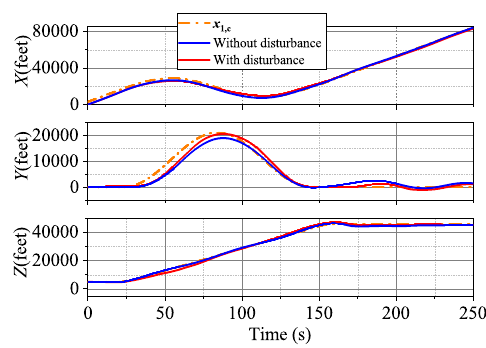
Figure 6. Results for X , Y , and Z .